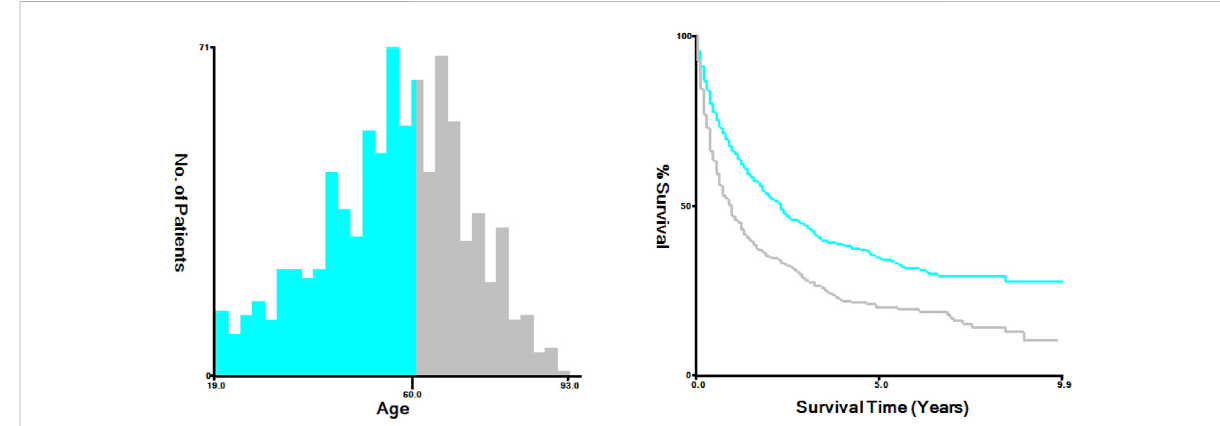
FIGURE 1 The ACC patients was divided into younger and elderly patients by the X-tile